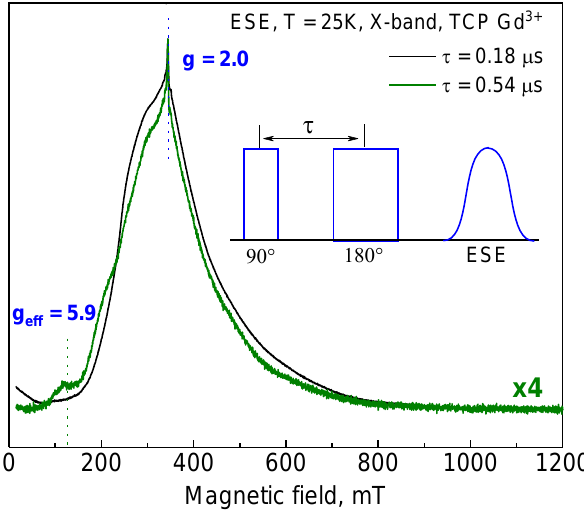
Figure 3. EPR spectra of a TCP sample with 0.001% Gd in pulsed mode at T = 25 K for two different values of τ indicated in the figure.